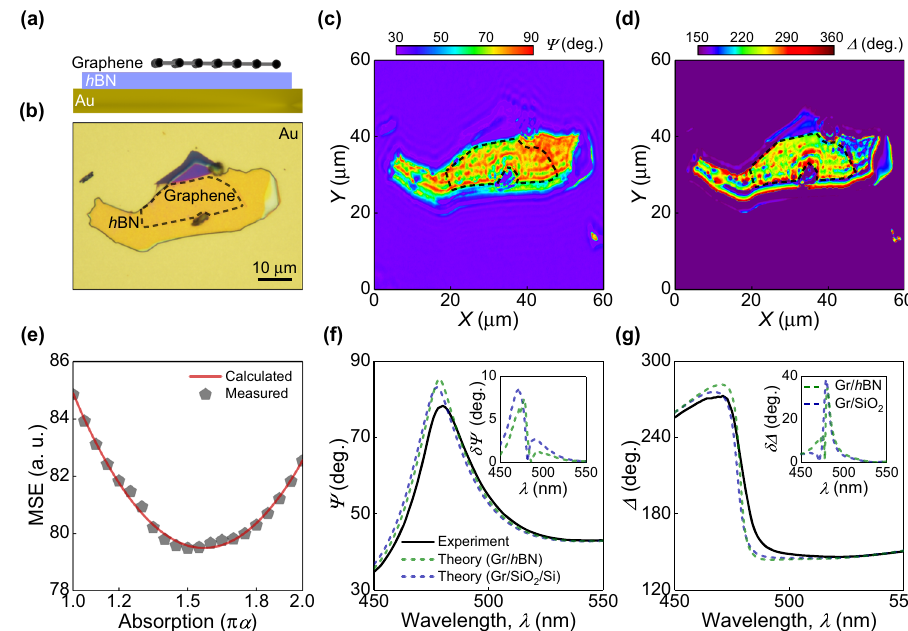
Fig. 3 Highly sensitive optical response to monolayer graphene in the vicinity of topological phase singularity. a Schematic illustration and b ×50 optical image of graphene on h BN/Au substrate. Ellipsometric parameter color maps of Ψ ( c ) and Δ ( d ) at the wavelengths of 477 nm and 50° angle of incidence near the topological phase singularity. The color bars show amplitude ( c ) and phase ( d ) distribution. Dashed lines are a guide to eye-emphasizing fl ake boundaries. e Evaluated (solid line) and measured (gray pentagons) mean squared error (MSE) dependence on the absorbance of graphene. Ellipsometric parameters Ψ ( f ) and Δ ( g ) near the topological phase singularity. Solid lines represent the measured parameters for graphene on h BN/Au substrate. Dashed lines correspond to the evaluated parameters. Insets show the exact variation between the evaluated and the measured